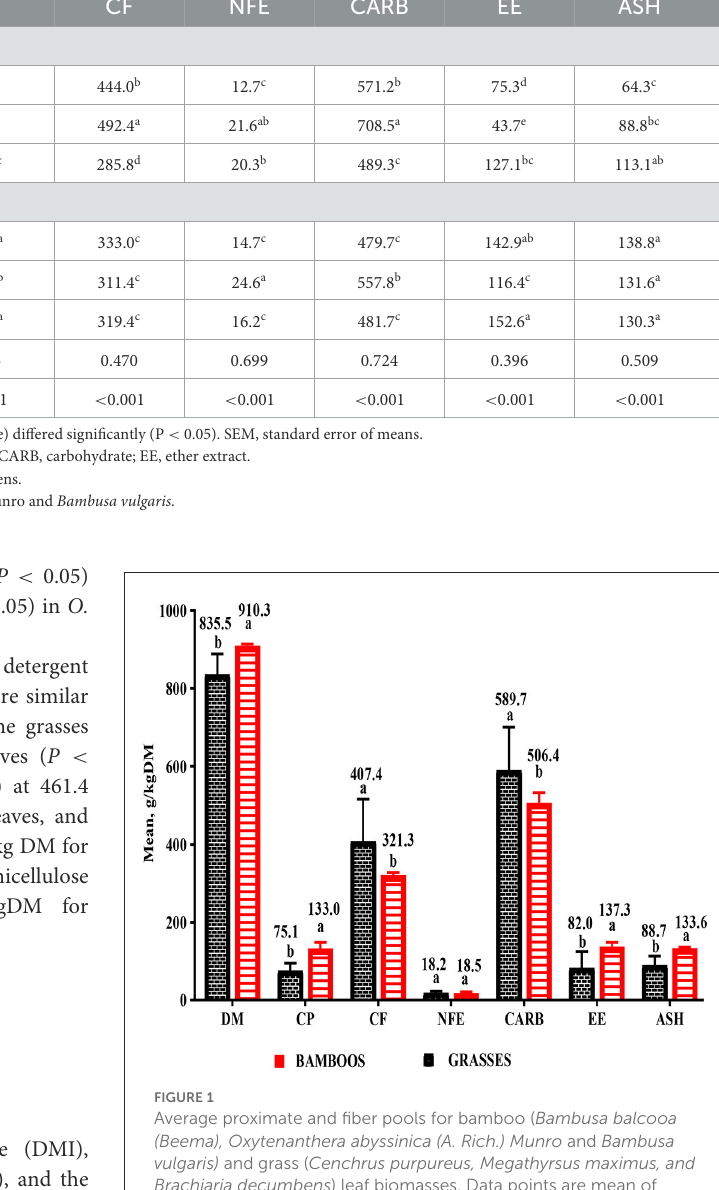
Composition (g/kgDM)